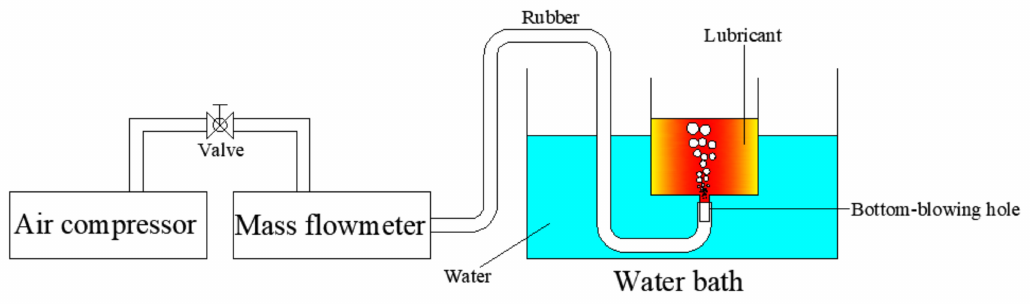
Figure 6. Connection diagram of the experimental device for physical model verification.